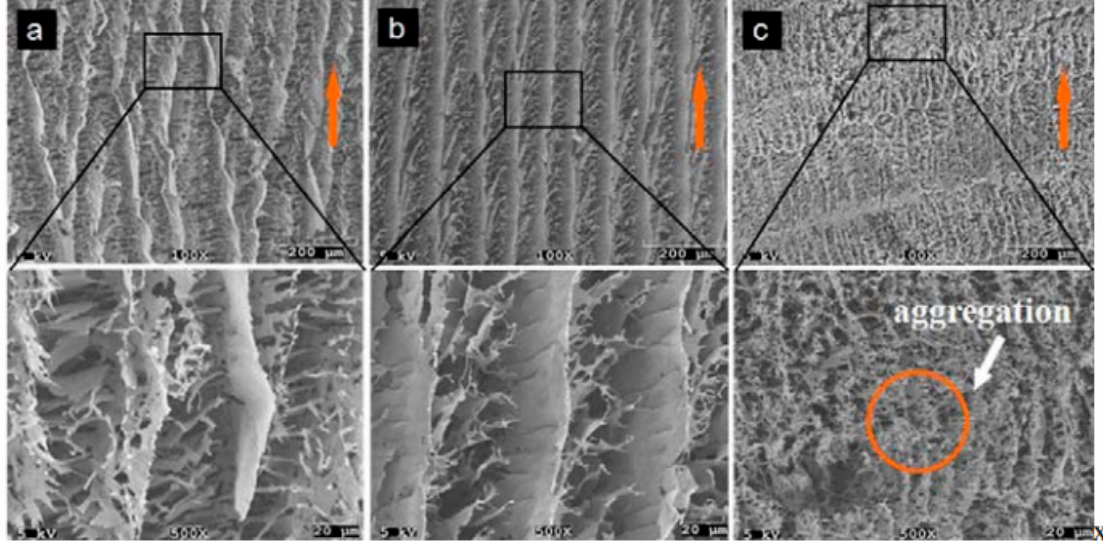
Figure 12. SEM images of CNW foams made with the various CNW suspensions under directional freezing. The suspension concentrations were ( a ) 0.4 wt %, ( b ) 0.8 wt %, ( c ) 1.2 wt %. Red arrows indicate the freezing directions [74].